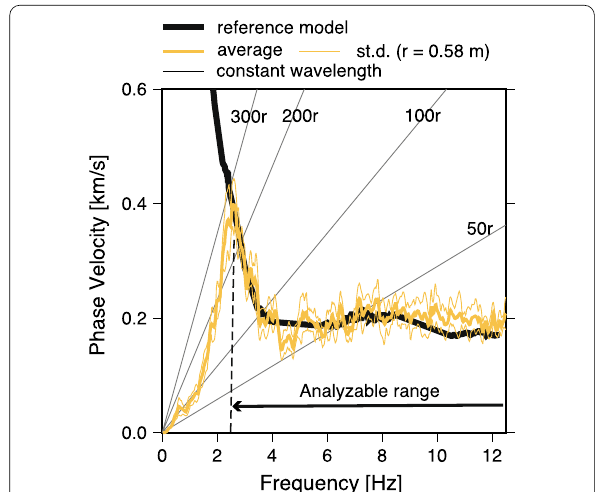
Fig. 1 Phase velocities obtained from an array with a radius of r 0.58 m. The thick yellow line represents average values and the = thin yellow lines show the standard deviations. A reference model (thick solid line) constructed based on arrays with radii from 5.8 m to 555 m (see the later section) is also plotted for reference. The four straight lines from the origin represent constant wavelengths of 50 r , 100 r , 200 r , and 300 r (the straight lines from the origin represent constant wavelengths; (phase velocity) (wavelength) (frequency)). × = The lowest limit of the analyzable frequency range (indicated by the arrow) corresponds to a wavelength of 269